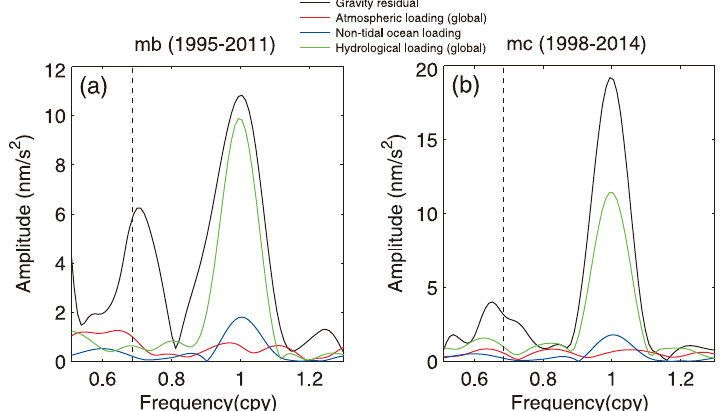
Figure 9. The Fourier spectra of the two residual SG records. (a) mb record; (b) mc record. The effects of the atmospheric loading (global), non-tidal ocean loading and the hydrological loading (global) are indicated by the red, blue and green curves,